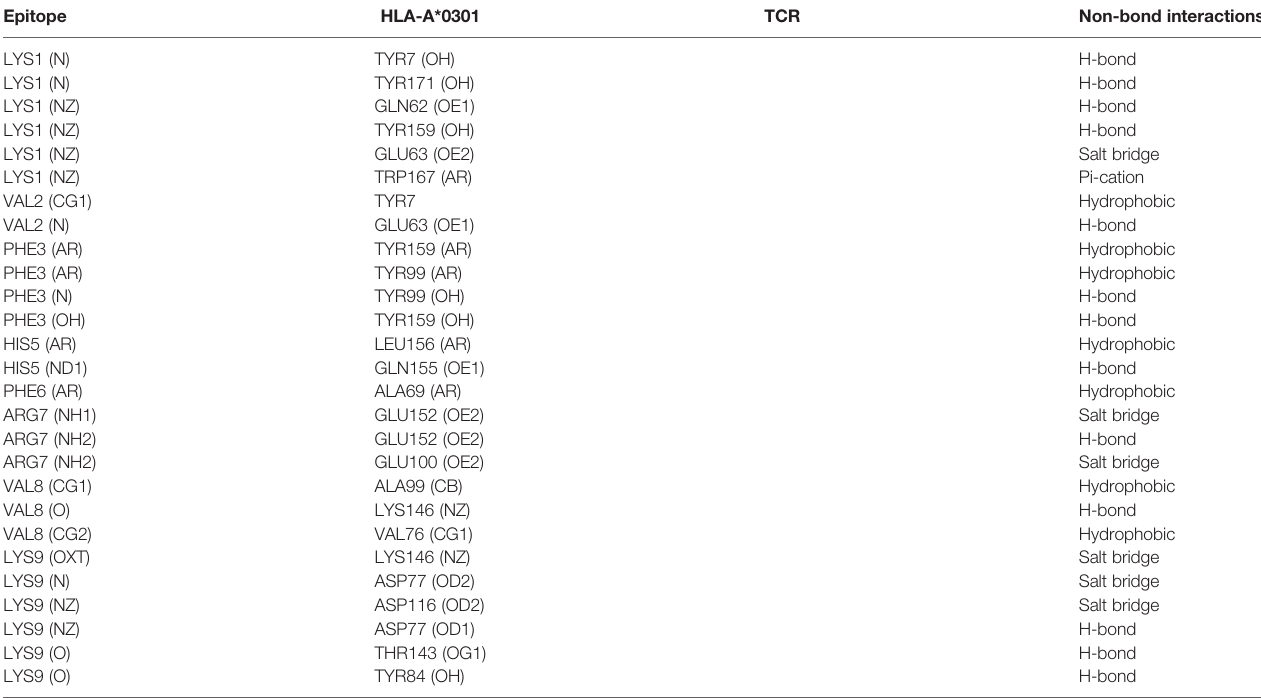
TABLE 1 | Intermolecular non-bond interactions established by the predicted epitope with HLA-A*0301 and TCR. Epitope HLA-A*0301 TCR Non-bond interactions LYS1